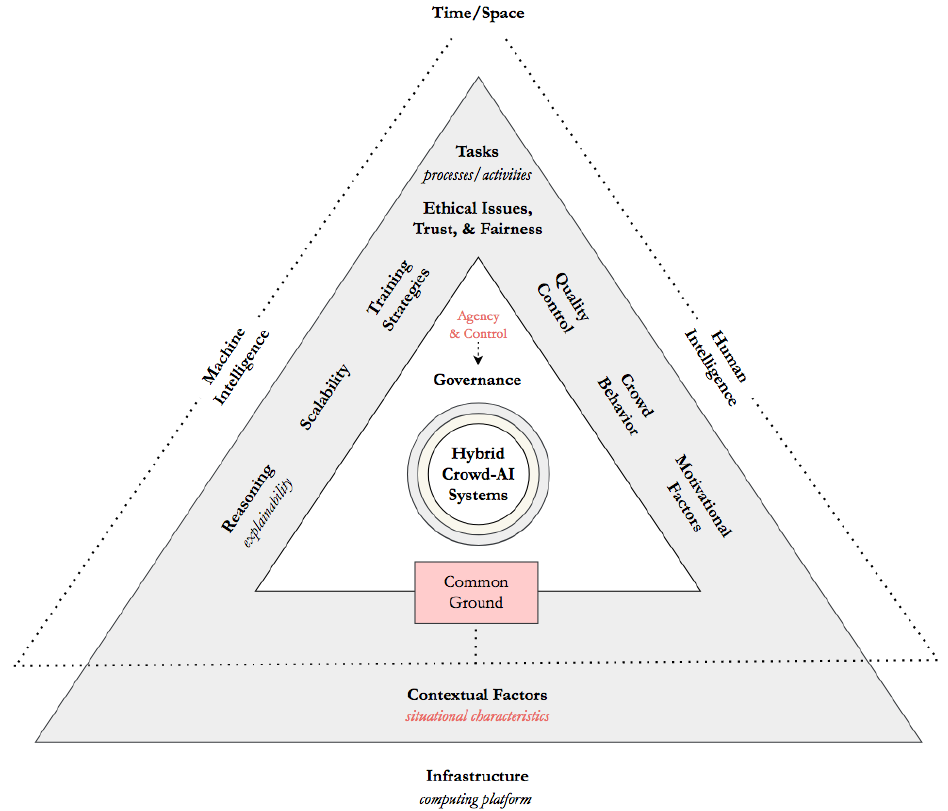
Figure 2. Taxonomy of hybrid crowd-AI systems. This taxonomic proposal integrates key conceptual dimensions of the human-centered AI framework introduced in [41] to characterize the configurations in which crowd-AI interaction occurs within the interplay between human and machine intelligence.